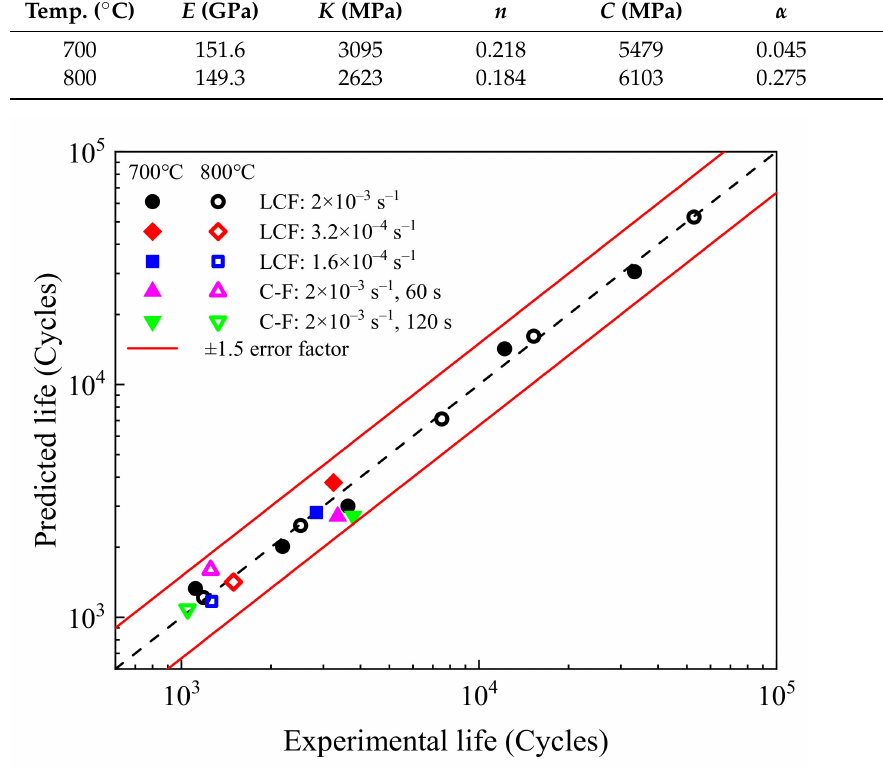
Table 3. Parameters of the life prediction model for Inconel 625 alloy.